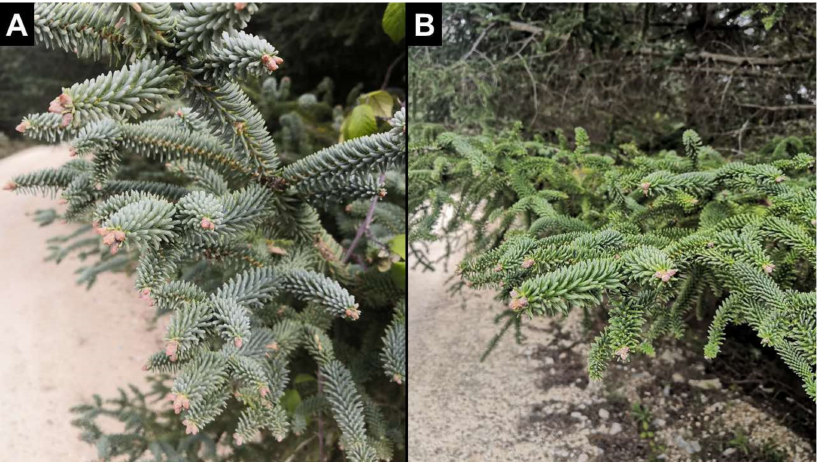
Figure 1. Image of the bluish ( A ) and green ( B ) needles of adult Spanish